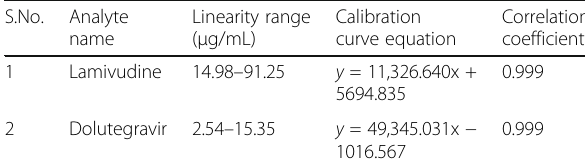
Table 2 Results of linearity